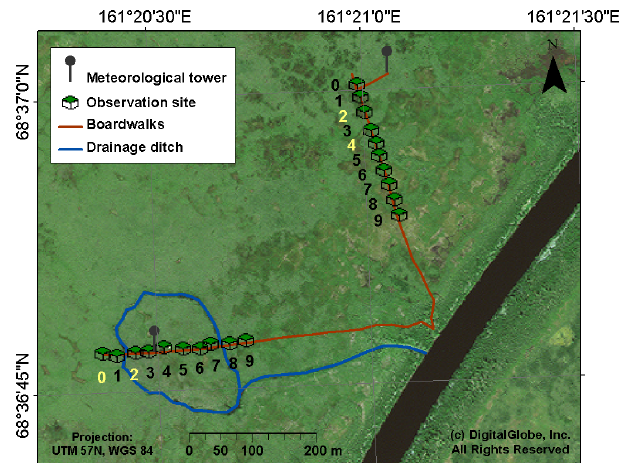
Figure 2. Aerial photograph of the site, including schematics of the drained (bottom left) and the control (top right) transects. Names of plots are written with numbers and two core plots for more fre- quent flux measurements are highlighted in yellow in each tran- sect. Fluxes, vegetation community structures (created using a non- destructive method), WTDs, and TDs were measured in all plots, and T soil were measured in even-numbered plots